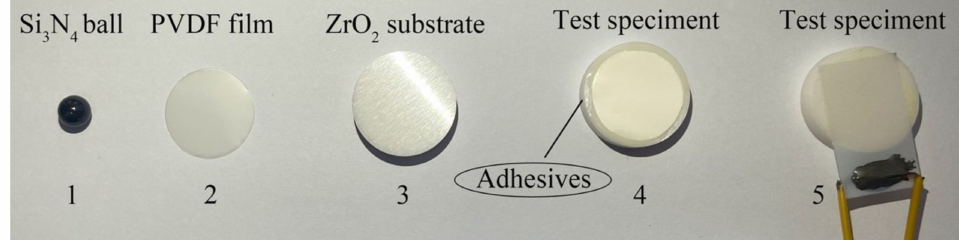
Figure 1. The ball and test specimen: 1—ball, 2—PVDF film, 3—ZrO 2 substrate, 4—test specimen without the voltage, 5—test specimen with the